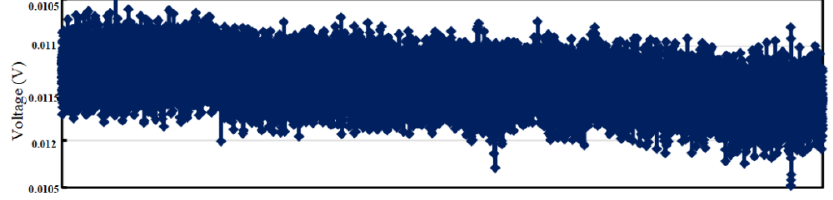
Figure 22. Test result of MEMS gyroscope zero bias output.